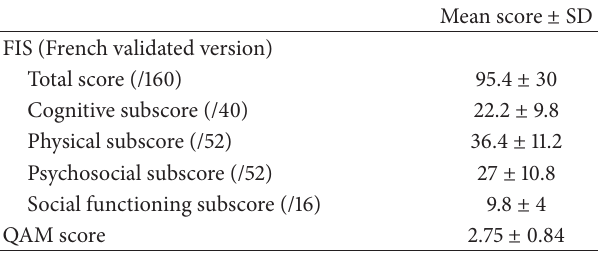
Table 1: Clinical and demographic characteristics of MS patients. Table 2: Fatigue scale and memory complaint scale scores.